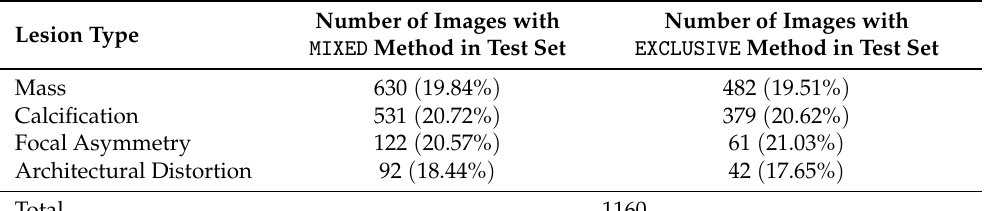
Table 2. Numbers of images for each lesion using MIXED and EXCLUSIVE method in the test set. In parentheses the percentage with respect to the entire